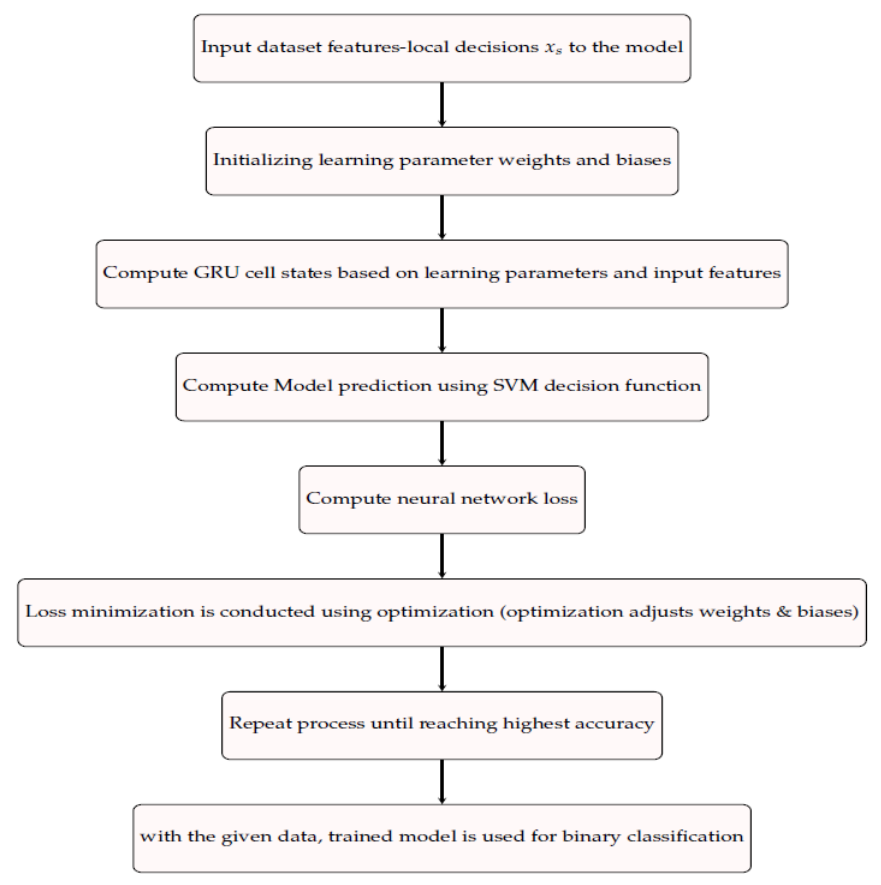
Figure 5. Flowchart for classification of malicious and legitimate users using GRU-SVM